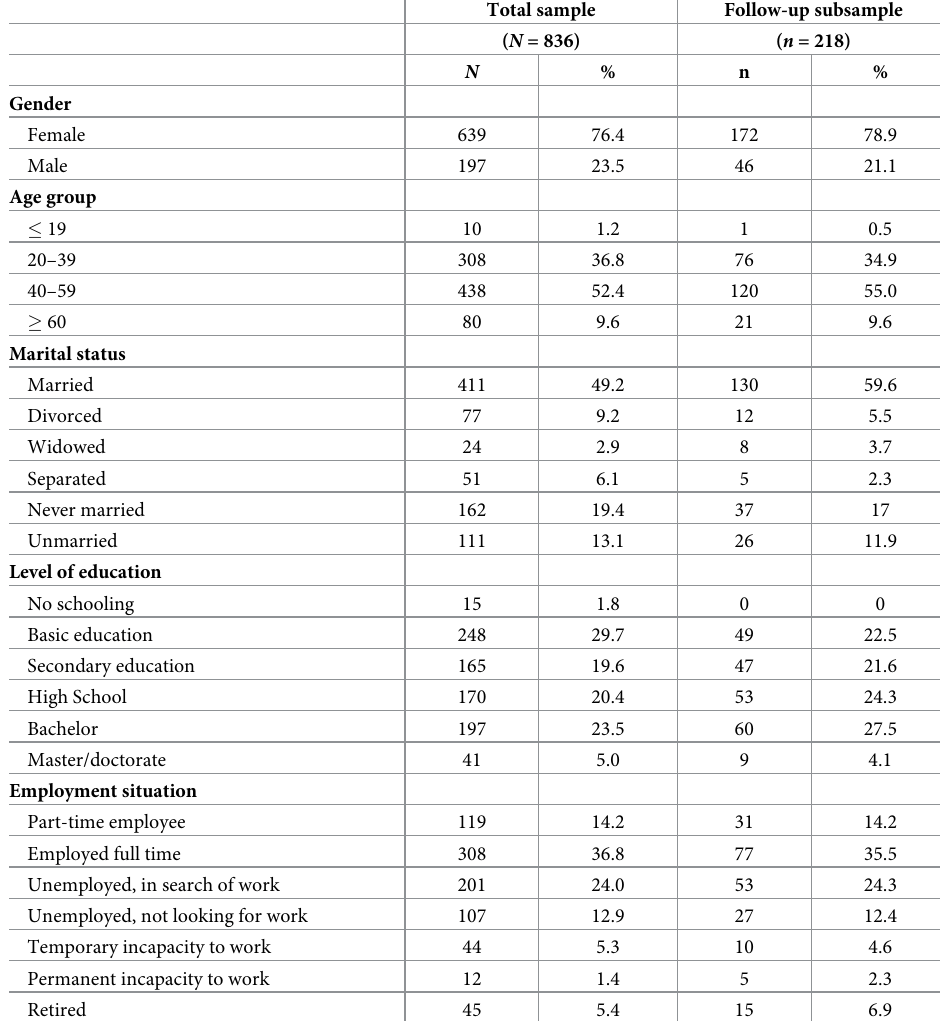
Table 1. Demographics characteristics of